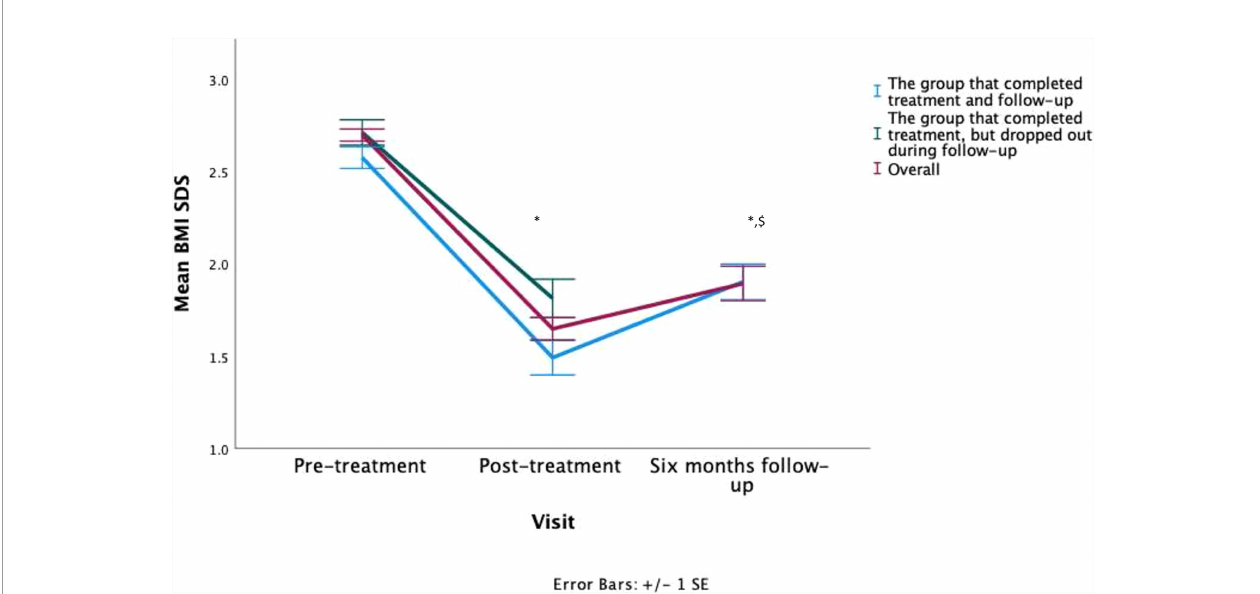
FIGURE 1 | Visual representation of the patients their BMI SDS evolution, * = statistically signi fi cant from baseline, $ = statistically signi fi cant from post-treatment. Both were